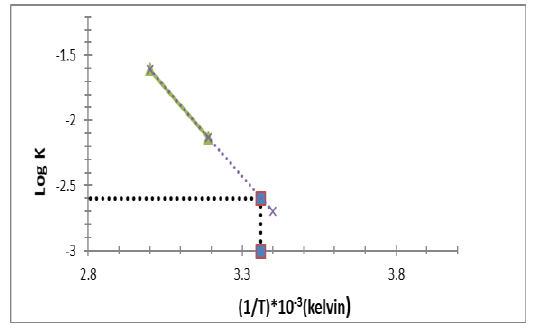
Figure 7. Arrhenius plot of carvedilol (F8)